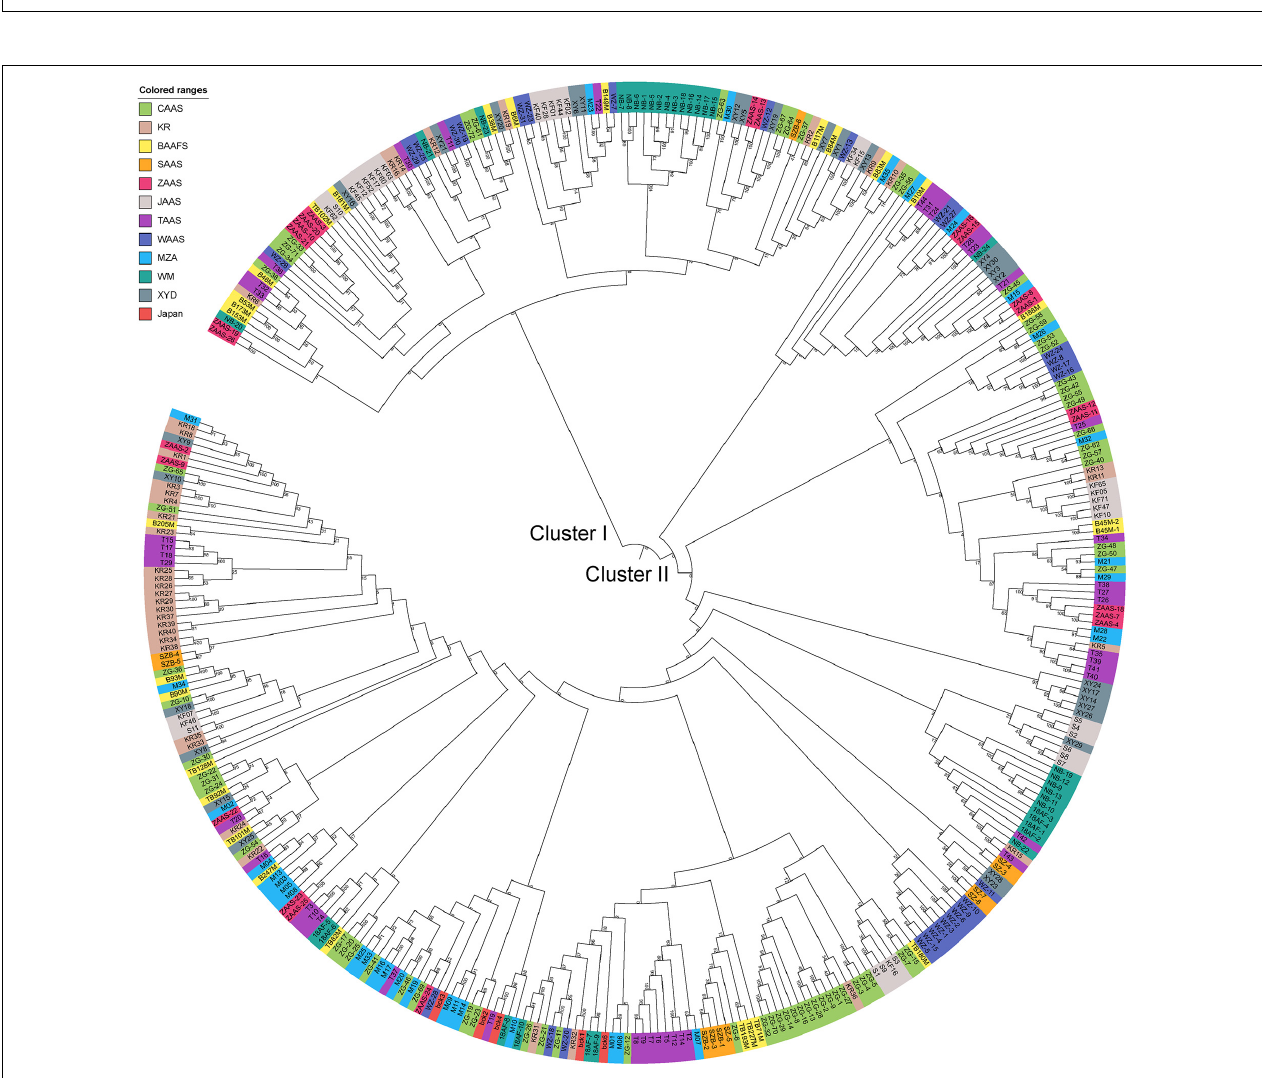
FIGURE 5 | Phylogenetic tree constructed using the neighbor-joining method based on 372 broccoli accessions. The colors in outer circle represent different sources of the accessions. CAAS, Chinese Academy of Agricultural Sciences; KR, Tianjin Kerun Vegetable Research Institute; BAAFS, Beijing Academy of Agriculture and Forestry Sciences; SAAS, Shanghai Academy of Agricultural Sciences; ZAAS, Zhejiang Academy of Agricultural Sciences; JAAS, Jiangsu Academy of Agricultural Sciences; TAAS, Taizhou Academy of Agricultural Sciences; WAAS, Wenzhou Academy of Agricultural Sciences; MZA, Zhejiang Mitsuo Seed Co., Ltd.; WM, Ningbo Weimeng Seed Co., Ltd.; XYD, Zhenjiang Xinyuanda Horticulture Technology Co., Ltd.; Japan, Sakata Seed Corporation, Japan.